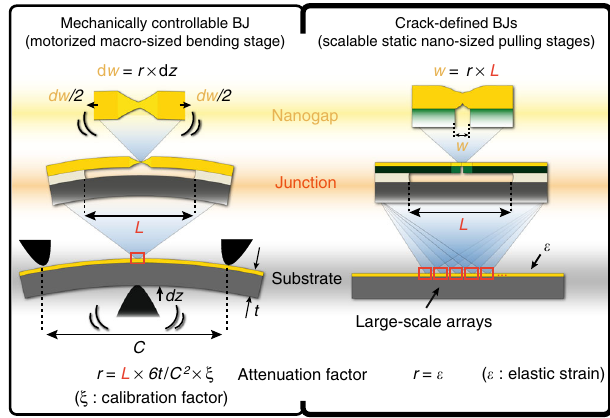
Fig. 7 Cross-sectional schematics of a MCBJ integrated in a 3-point bending stage and of CDBJs. The dynamically controllable mechanically controllable break junction (MCBJ) allows for continuous monitoring of the breaking process and tuning of the resulting inter-electrode separation. However, the need to maintain a precise substrate curvature restricts the usability to single junctions. In contrast, a crack-de fi ned break junction (CDBJ) has a fi xed pulling action, but the self-breaking process triggered by crack formation and retraction of the cantilevers is highly parallelizable and can be applied to large-scale arrays of many thousands of break junctions simultaneously. Further, unlike in a MCBJ 3-point bending stage, the attenuation factor of a CDBJ is known prior to breaking as it is equal to the elastic strain of the bridge material. It is worth noting that any CDBJ fabricated in this work can also be integrated in a 3-point bending stage that, assuming a typical bridge geometry, has an attenuation factor r ~ 6 Lt / C 2 = 6 × 1 × 10 − 6 × 5 × 10 − 4 /(2.5 × 10 − 2 ) 2 ≈ 5 × 10 −